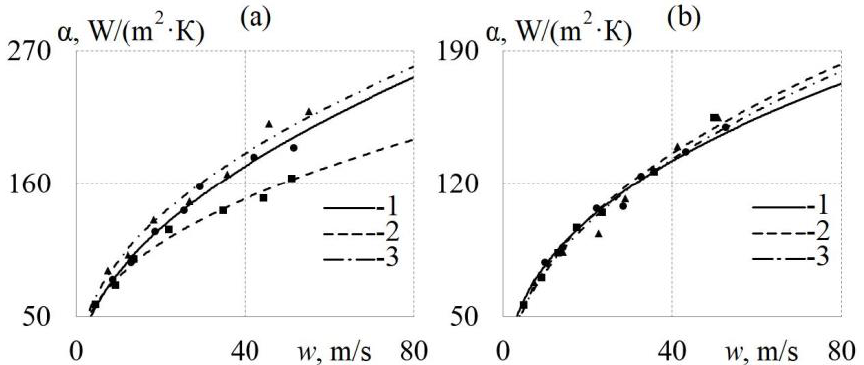
Figure 9. Dependences of the local heat transfer coefficient α o n the average air velocity w in round (1), square (2), and triangular (3) pipes with a turbulator (TI = 0.12) for different control sections: ( а ) l x = 100 mm; ( b ) l x = 300 mm.